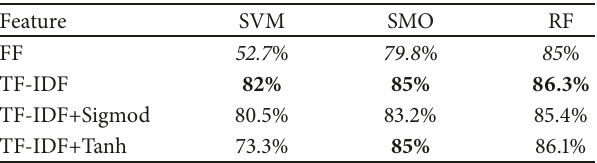
Table 7: Recognition precisions using three classifiers concerning dataset cairo.